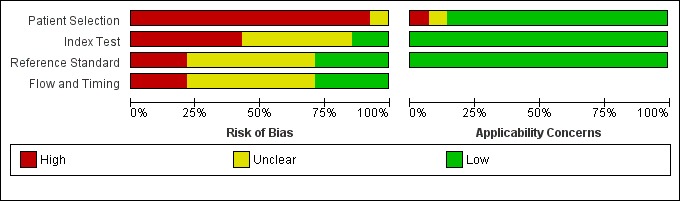
Proportion graph of studies assessed as having low, high, or unclear risk of bias and/or applicability concerns.